Question: What does this figure show? Answer in one sentence.
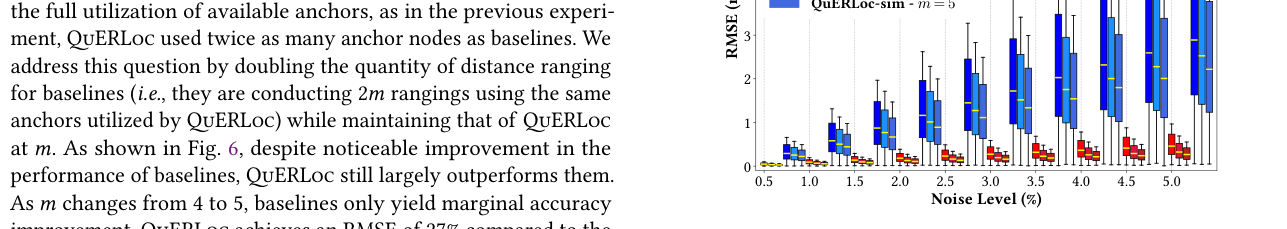
Answer: Comparison of QuERLoc and QuERLoc-sim with 𝑚= 3, 4, 5 under non-zero noise levels 0.5% to 5%. Each cluster of boxes corresponds to one noise level.